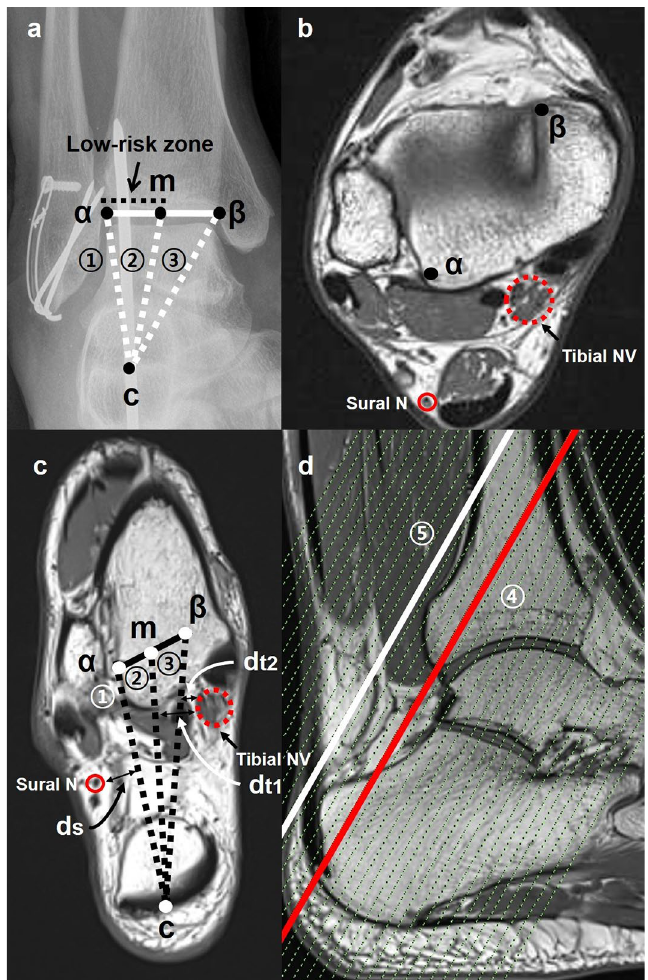
Figure 5. (a) The C-arm fluoroscopic ankle mortise radiograph is used during pin insertion. The low-risk zone on the simple radiograph was transferred to the MRI to measure the distance between its borders and the neurovascular structures . (b) On the axial image, the lateral end of the posterior malleolus at the joint level (α) and the anteromedial end of the anterior distal tibial articular surface (β) are marked. The marks can be shown in every oblique axial slice using Pictured Archives and Communication System (PACS). (c) The oblique axial slice, oriented on the trajectory of the pin fixation (from the center of the calcaneal tuberosity to the distal tip of the posterior malleolus: ④ ), was selected for the measurement. A line was drawn connecting the two ends (α, β). Then, a line was drawn from the center of the calcaneal tuberosity (c) bisecting (m) the line connecting the two ends (α, β), indicating the medial border of the low-risk zone ( ② ). Also, for the low-risk zone’s lateral border ( ① ), a line was drawn from the center of the calcaneal tuberosity (c) to the lateral end of the posterior malleolus (α). Similarly, for the most medial border ( ③ ), a line was drawn from the center of the calcaneal tuberosity (c) to the anteromedial end of the anterior distal tibial articular surface (β), allowing us to confirm the safety of aiming the pin toward the medial end of the anterior distal tibial articular surface during fixation. The three borders of the low-risk zone are observable in every oblique slice using PACS. The distance (d s ) between the sural nerve (closed circle) and the lateral border of the low-risk zone ( ① ), (d t1 ) the posterior tibial neurovascular structures (dotted circle) and the medial border of the low-risk zone ( ② ), and (d t2 ) the posterior tibial neurovascular structures and the most medial border of the low-risk zone ( ③ ) were measured. (d) Five additional consecutive oblique axial slices within 1 cm proximal from the distal tip of the posterior malleolus ( ④ ) were recorded to determine the safety of inserting the pin into the posterior malleolus 1 cm proximal from the distal tip ( ⑤